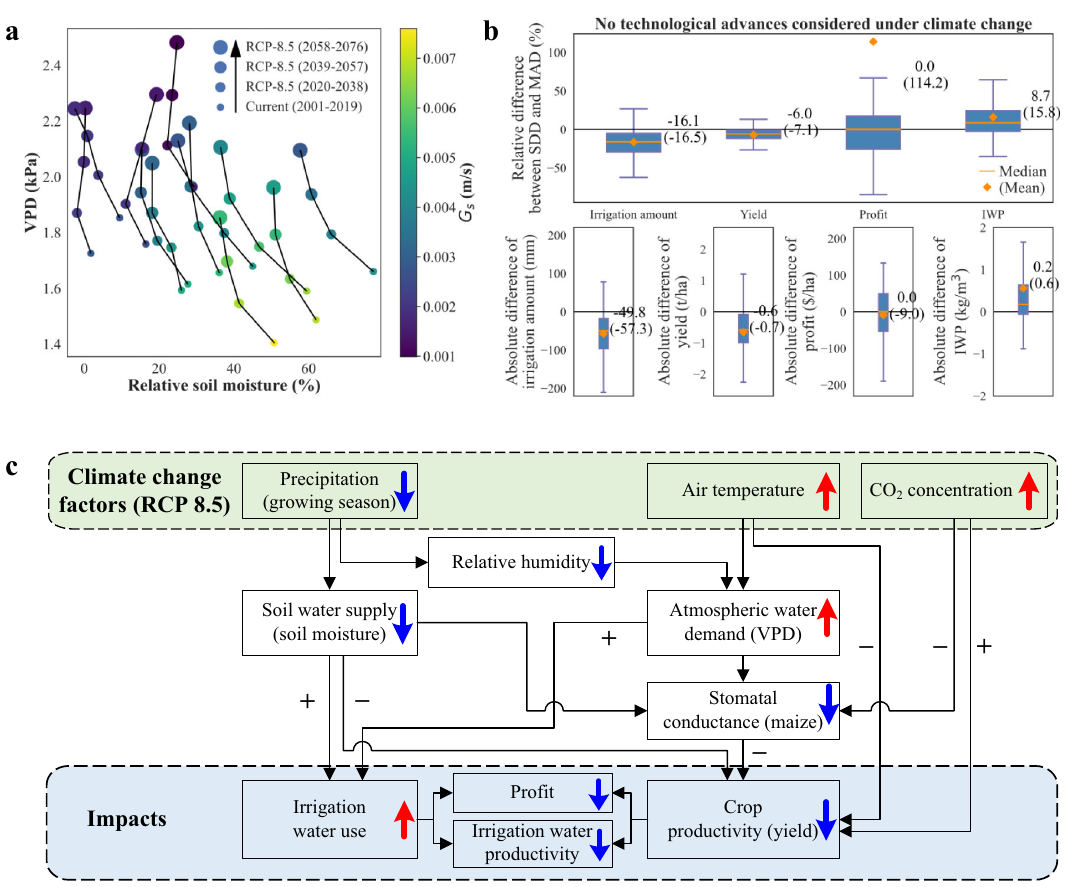
Fig. 6 The impacts of climate change on irrigation water use and crop productivity. a The simulated shifts of soil water supply (soil moisture), atmospheric evaporative demand (VPD), and stomatal conductance ( G s ) without irrigation under current climate (2001 – 2019) and over three continuous time periods (2020 – 2038, 2039 – 2057, and 2058 – 2076) under RCP-8.5 scenario. Each point showed the averages of daily soil moisture, VPD, and G s during the peak growing season (July and August) in each scenario at 12 sites in Nebraska. Relative soil moisture, the ratio (in percentage) of available water to fi eld capacity, was applied to avoid the impact of heterogeneous soil properties at 12 sites. b The performances of the plant-centric SDD and soil- moisture-based MAD irrigation schemes with universal parameters under the RCP-8.5 scenario (2058 – 2076) (similar to Fig. 5) without considering technological advances on crop yields. c The schematic diagram of the main processes by which climate change affects irrigation water use and crop